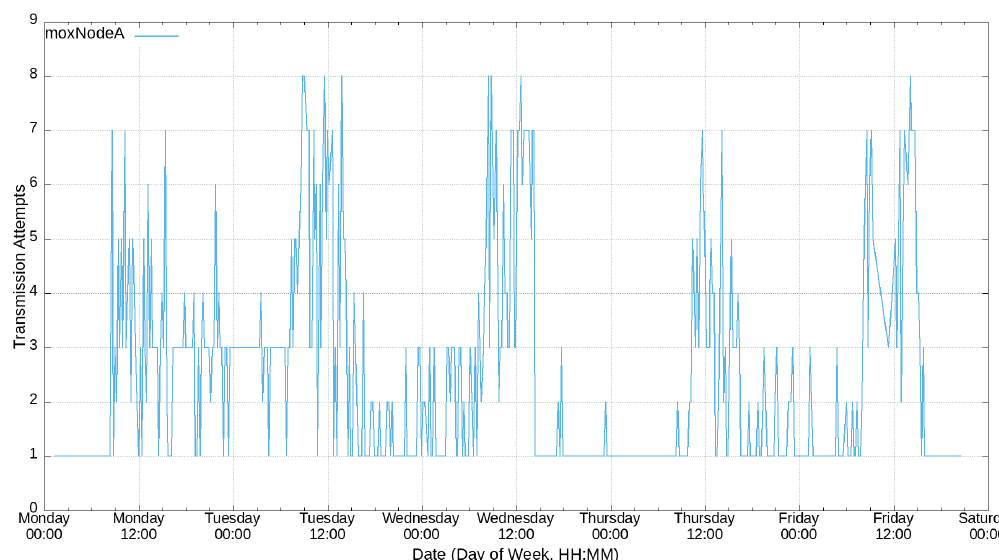
Figure 11. LoRaWAN re-transmissions during weekdays and a bank holiday